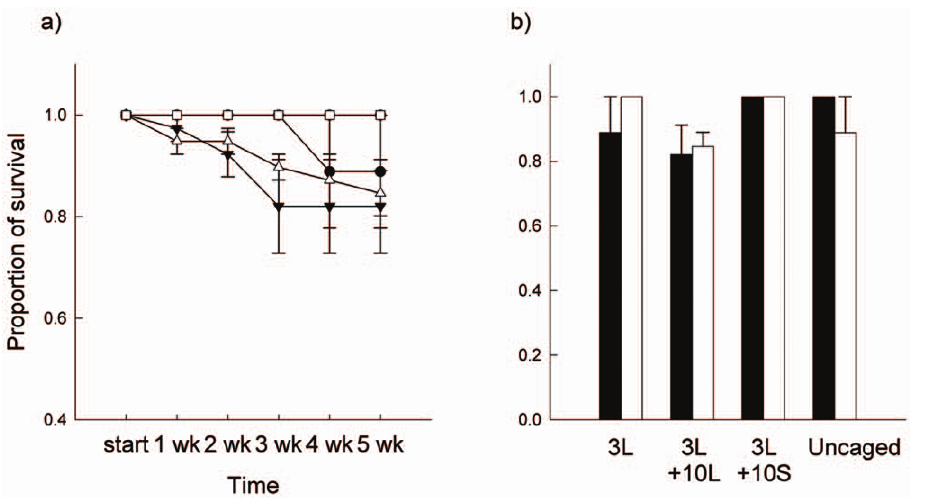
Figure 2. Survival of large limpets. Mean ( 6 SE; n =3) proportion of survival of large P. vulgata for each week (wk; a) or at the end of the experiment (b). Treatments are: 3L (circles), 3L + 10L (triangles), 3L + 10S (squares). S, small limpets; L, large limpets. Black symbols and bars, without macroalgae; white symbols and bars, with macroalgae.